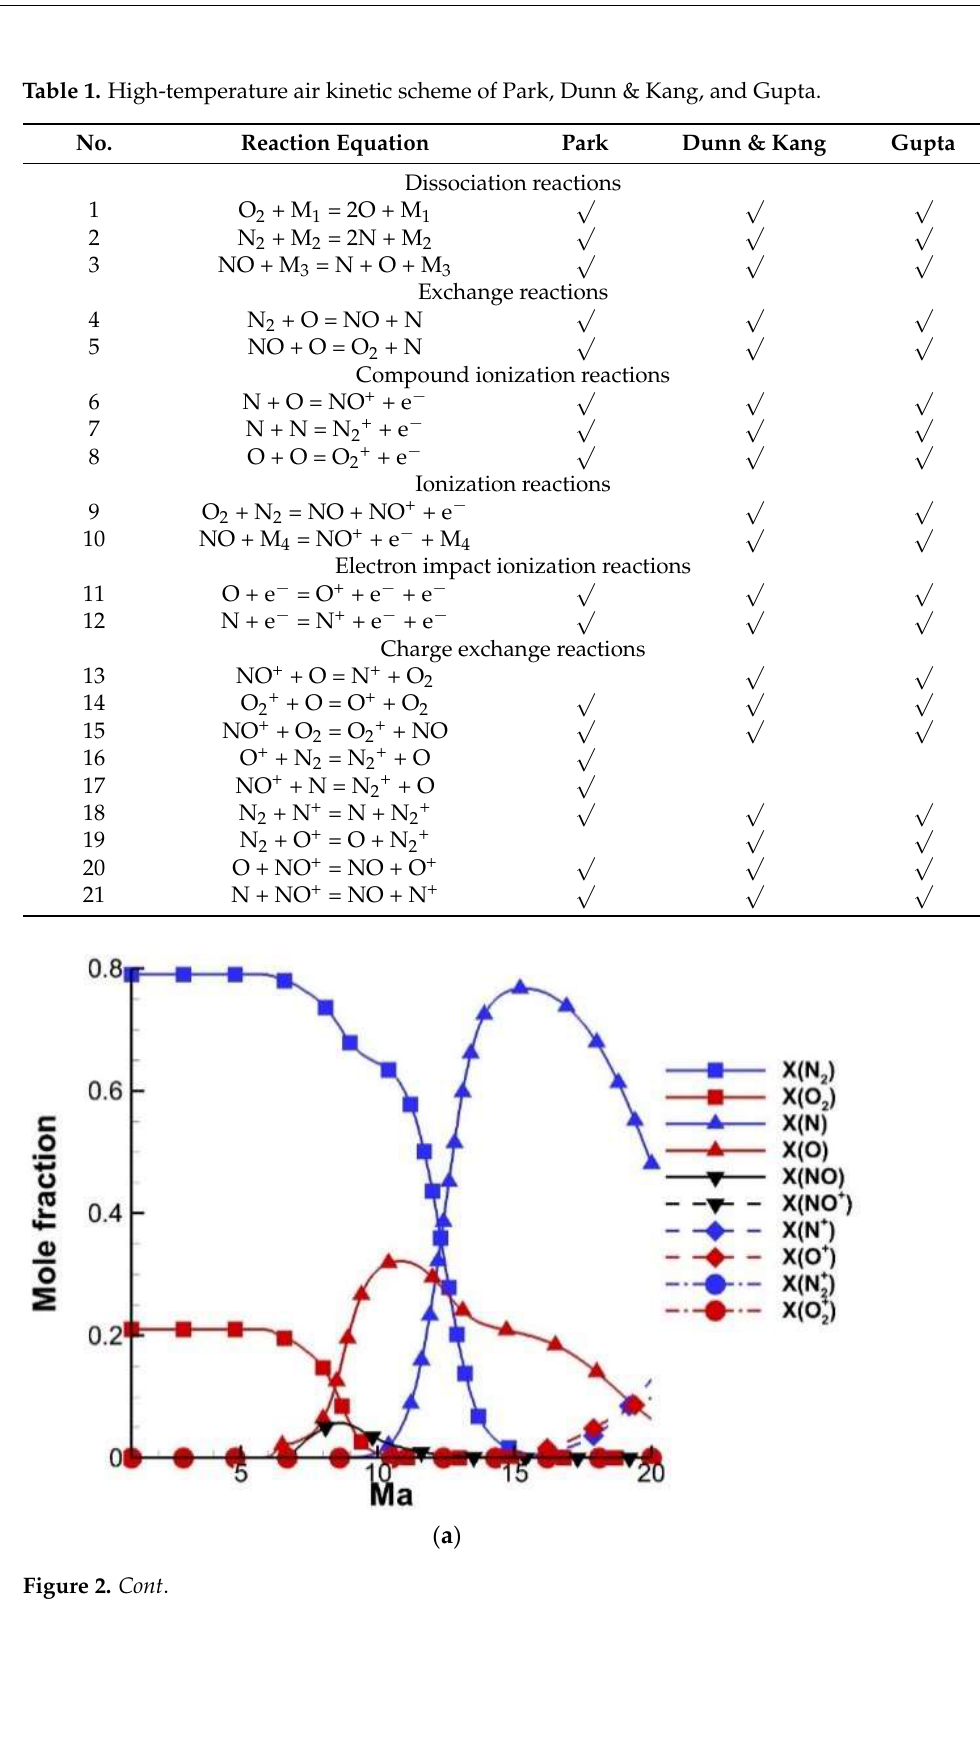
Table 1. High-temperature air kinetic scheme of Park, Dunn & Kang, and Gupta. No.